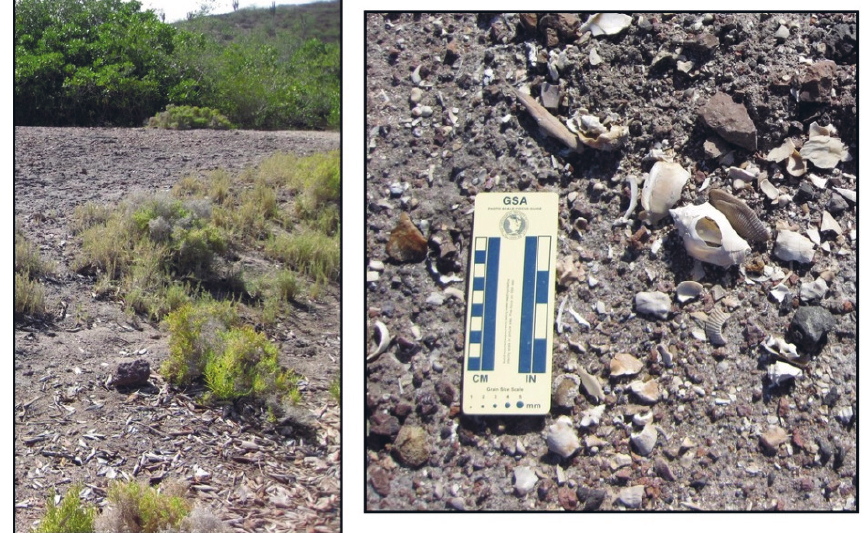
Figure 6. Area C. Area C is a mound of mixed materials, formed at the eastern edge of the lake at the base of a steep slope; thickness is ~60 cm.